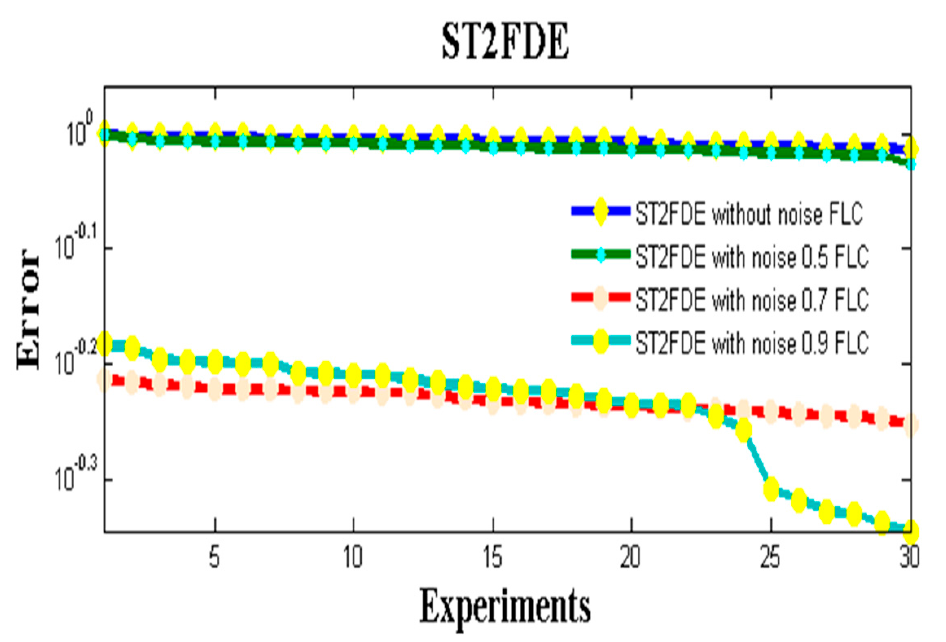
Figure 16. Graphical representation of the error using ST2FDE without noise and with different noise levels.